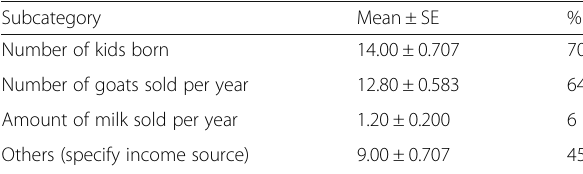
Table 4 Importance of product categories of goats in rural areas of the Nile Delta in Egypt